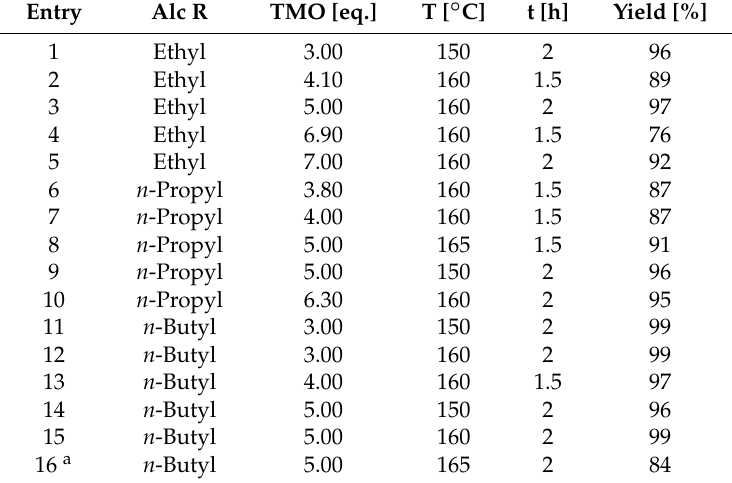
Table 2. Reaction conditions for the N-formylation of alanine alkyl